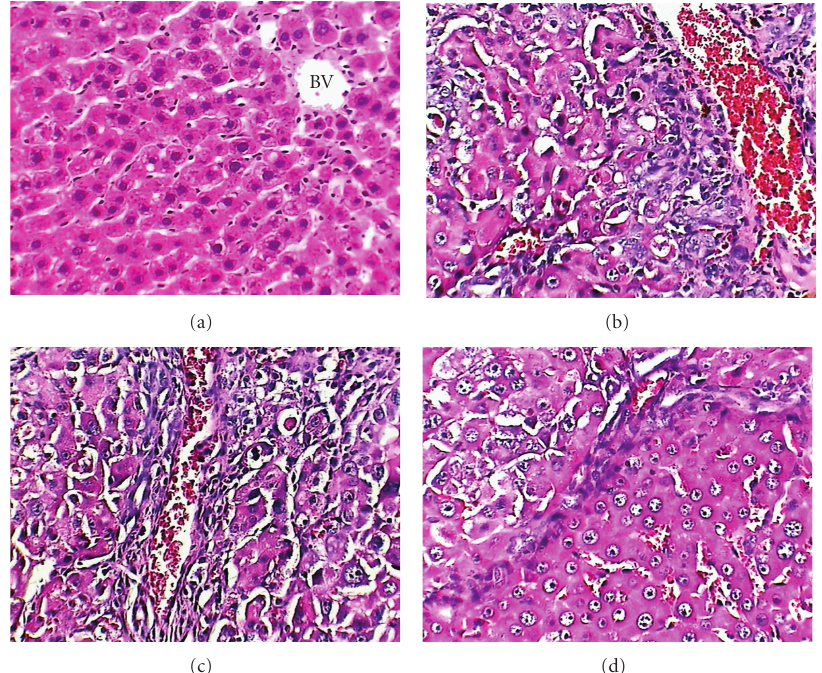
Figure 2: Liver micrographs of control (a), malathion ((b) and (c)), and malathion plus α -lipoic acid (d) treated rats. Original magnification X400.